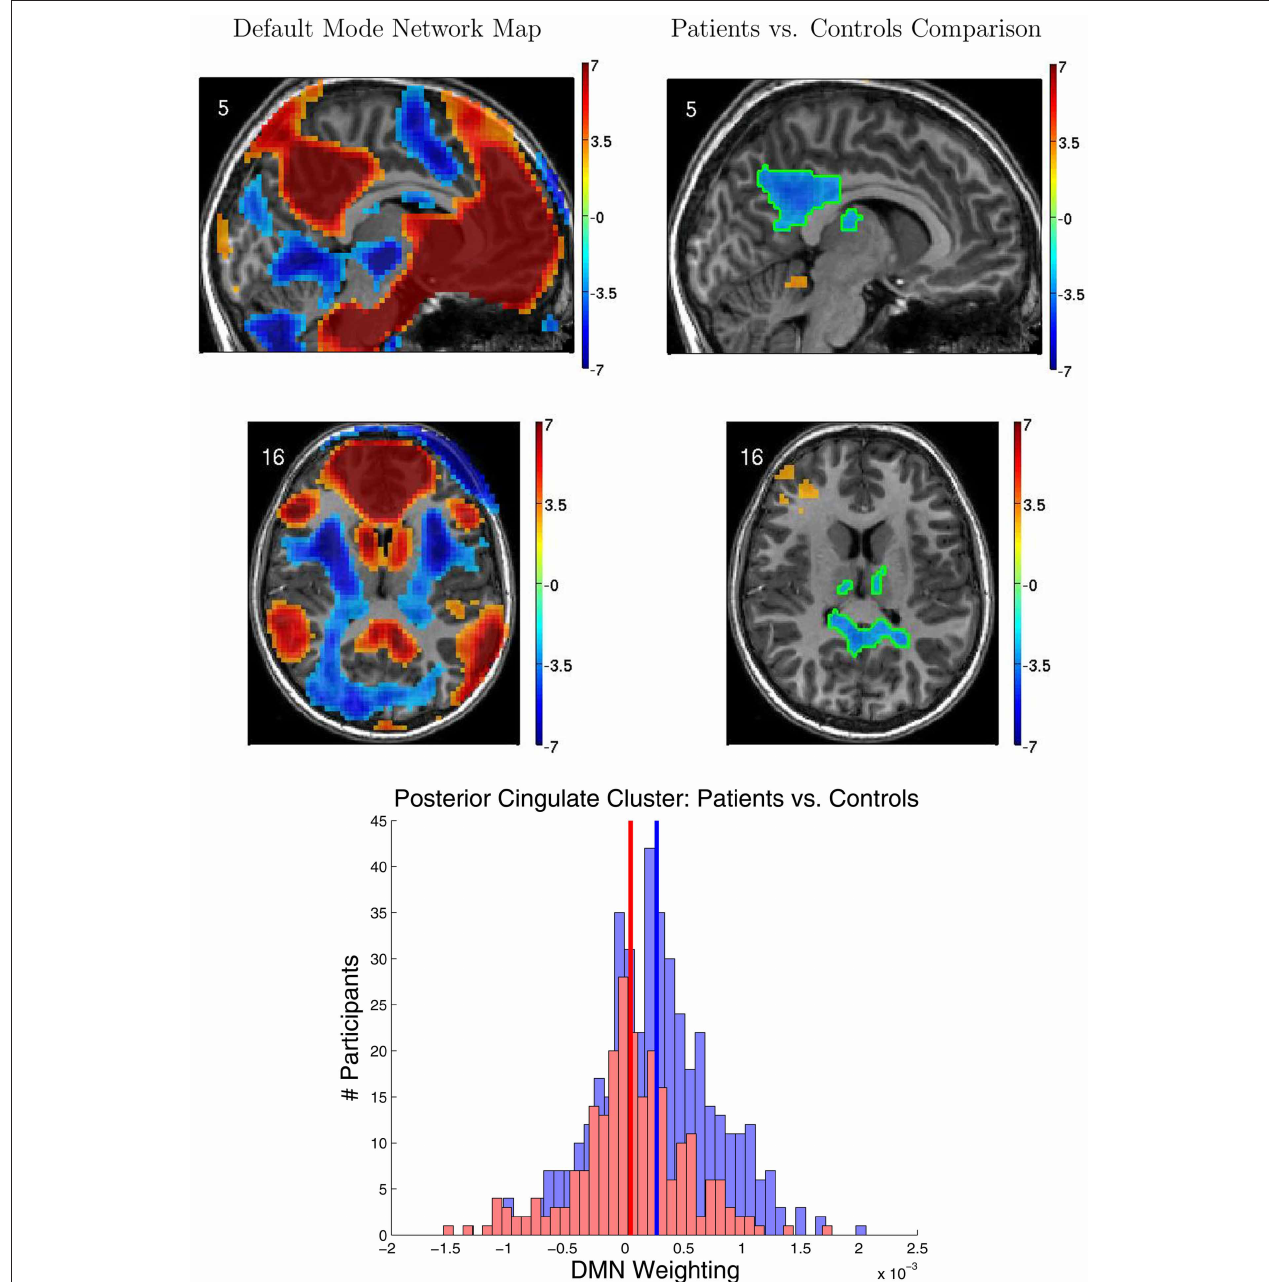
FIGURE 5 | Results from functional connectivity group analysis. Top-left : A midline sagittal slice from a statistical map of voxels with significant weighting for the default mode network (DMN) in 668 participants. Red regions were positively weighted on the DMN. Blue regions were negatively weighted. Front of brain is on the right side of the image. Colored bar indicates t -value scaling. The slice’s coordinate in mm in MNI space is shown in the upper-left corner. All results p < 0 . 05 corrected for multiple comparisons. Middle-left : Axial slice of same DMN weighting map as shown in upper-left panel. Left side of brain is on left side of image. Other conventions as in top-left panel. Top-right : Sagittal slice from a contrast map comparing DMN weighting for 239 ADHD patients vs. 429 healthy controls. Red regions showed greater DMN